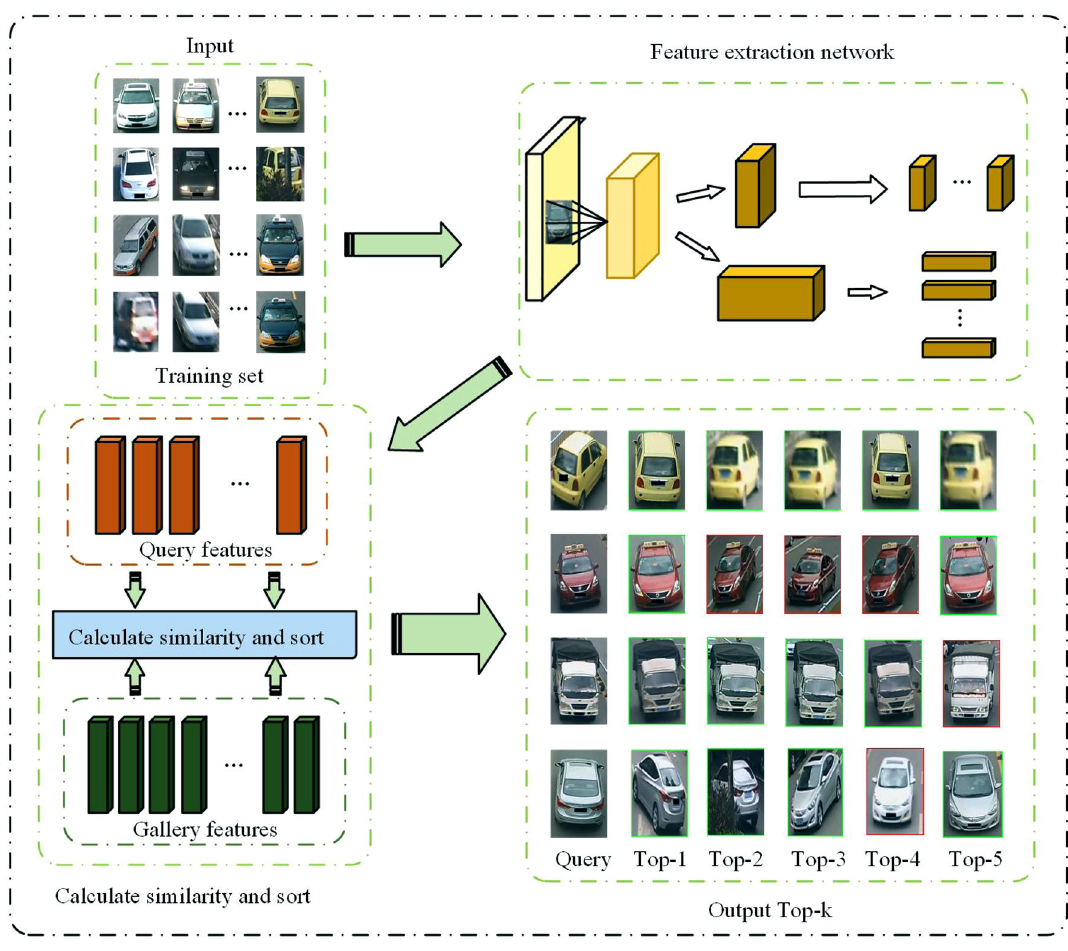
Figure 2. The overall framework of the algorithm